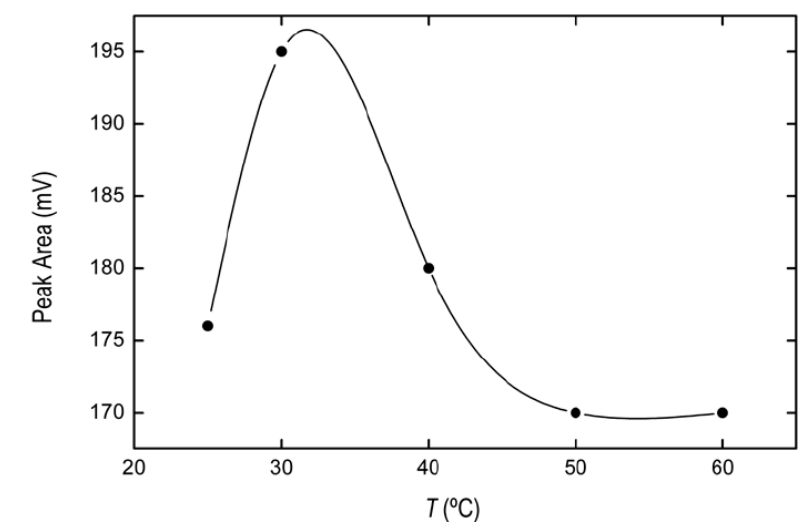
Figure 2. Effect of the temperature on the BPA signal obtained from IL phase. Solid line represents spline connectors. Maximum extraction efficiency was achieved at T = 30 °C.